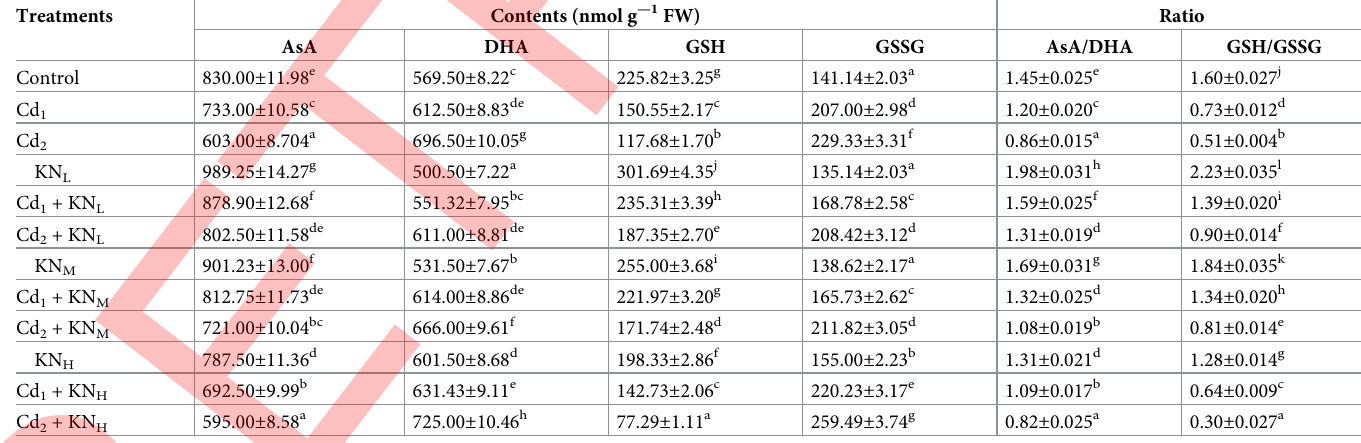
Data represent the mean value ± standard error from three replicates (n = 3). Values followed by the different superscripts within same column differ at P < 0.05 among the treatments by